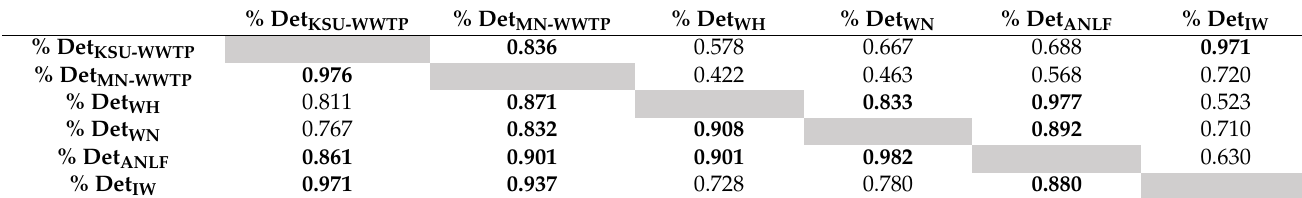
Table 2. Pearson’s correlation matrix of HAdV detection percentage at the various sampling areas.